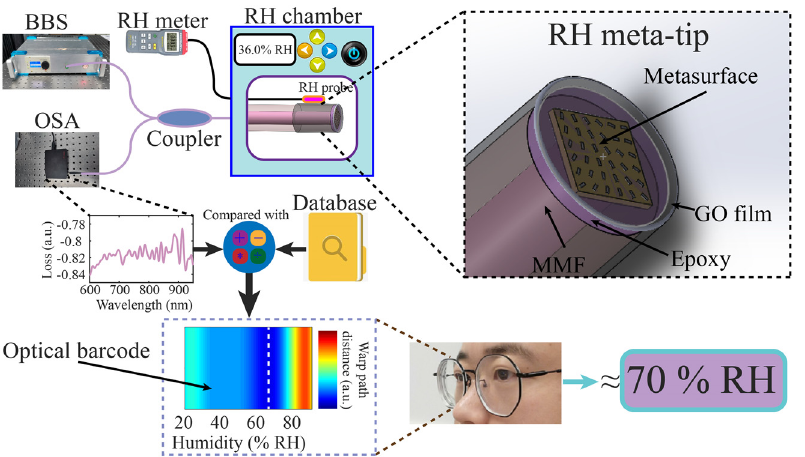
Figure 1: Schematic of RH measurement using the optical barcode technique.